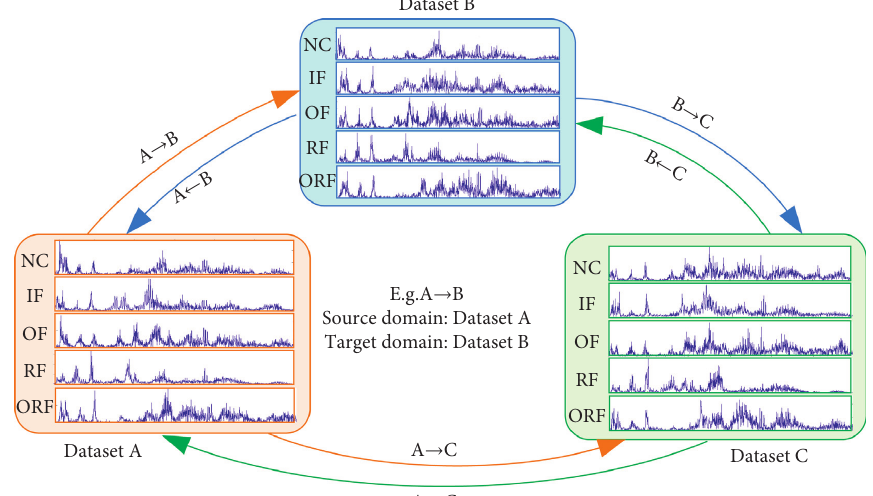
Figure 2: Six transfer fault diagnosis cases.